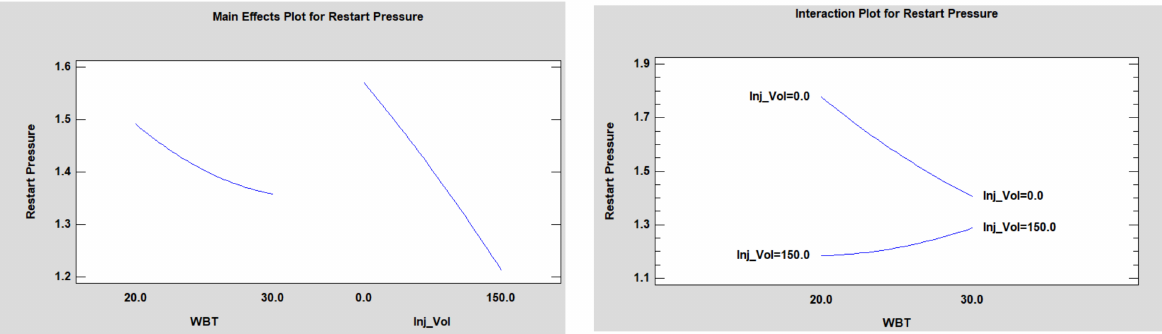
Figure 4. Main effect and interaction plots for the restart pressure during the instantaneous